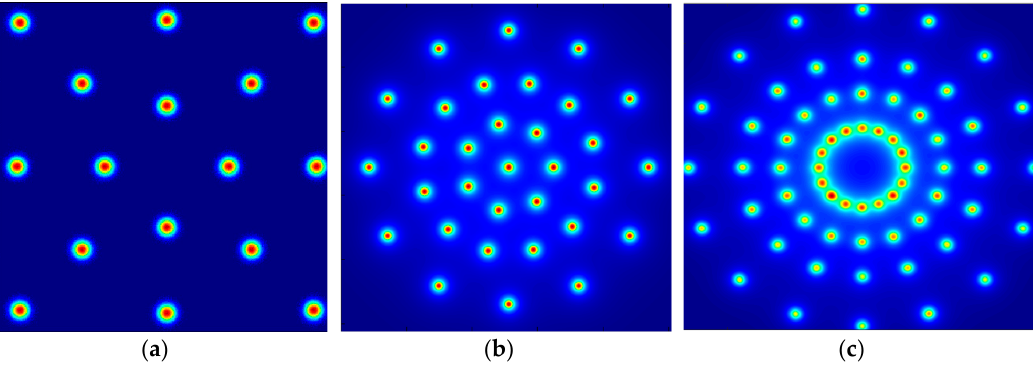
Figure 3. GS-QAM formats based on ( a ) maximizing constellation figure of merit, ( b ) minimizing mean-square error of Gaussian distribution, and ( c ) maximizing generalized mutual information (GMI).